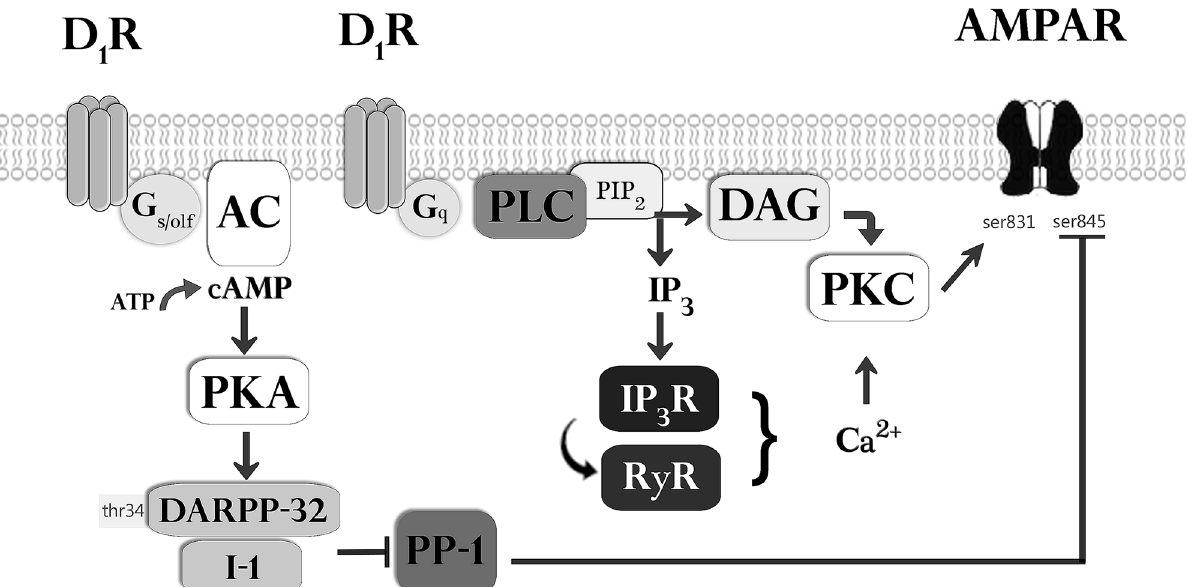
Fig 5. Proposed signaling pathways that govern the dopaminergic facilitation of AMPA-mediated EPSCs. Classical D 1 -receptors are coupled to adenylyl cyclase (AC) via G s/olf proteins, and we have shown previously that the dopamine-induced facilitation is dependent upon the activity of both protein kinase A (PKA) and protein phosphatase 1 (PP1) [20]. The PKA-mediated activation of inhibitor 1 (I-1) or of DARPP32 (dopamine and cyclic AMP regulated phosphoprotein 32) at thr 34 may inhibit activity of protein phosphatase 1 (PP1) and thereby potentiate EPSCs by reducing the dephosphorylation of AMPA GluR1 receptor subunits at ser 845 . The present results indicate that activation of D 1 -receptors coupled to phospholipase C (PLC) via G q proteins is also required for the facilitation of EPSCs. PLC leads to production of diacylglycerol (DAG) and InsP 3 from PIP 2 . InsP 3 triggers Ca 2+ release from internal stores via InsP 3 receptor (InsP 3 R) activation, and may also trigger Ca 2+ induced Ca 2+ release via ryanodine receptors (RyR). Both increased cytosolic Ca 2+ and DAG can activate protein kinase C (PKC) that can enhance AMPA receptor function via phosphorylation at ser 831 .